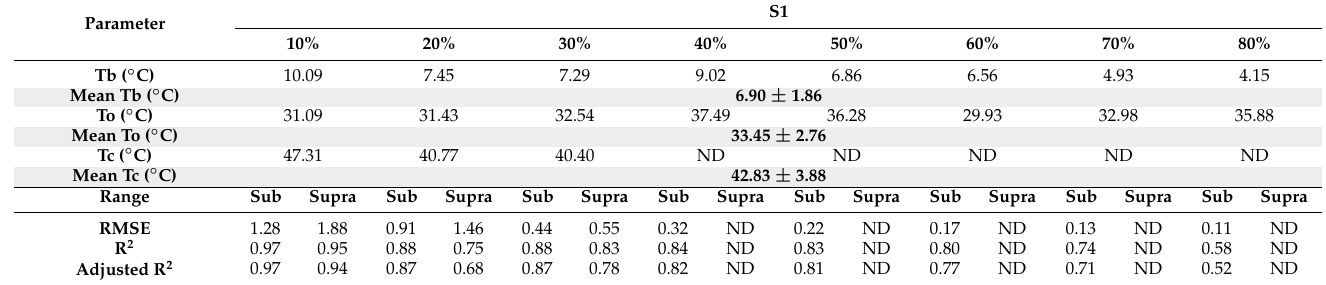
a range of 2.45 °C. For the S3 model, Tb varies in a range of 9.1 °C, To varies 4.05 °C, and Tc in a range of 11.62 °C. For the B1 model (Table 6), Tb variation difference was 17.38 °C (for 50–80% estimated Tb was negative), To difference was 0.87 °C, and Tc difference was 6.47 °C; for the B2 model Tb variation difference was 9.48 °C, To was 5.42 °C, and Tc dif- ference was 7.38 °C; and finally, for the B3 model Tb variation difference was 12.85 °C, To was about 1.13 °C, and Tc difference was 16.49 °C.